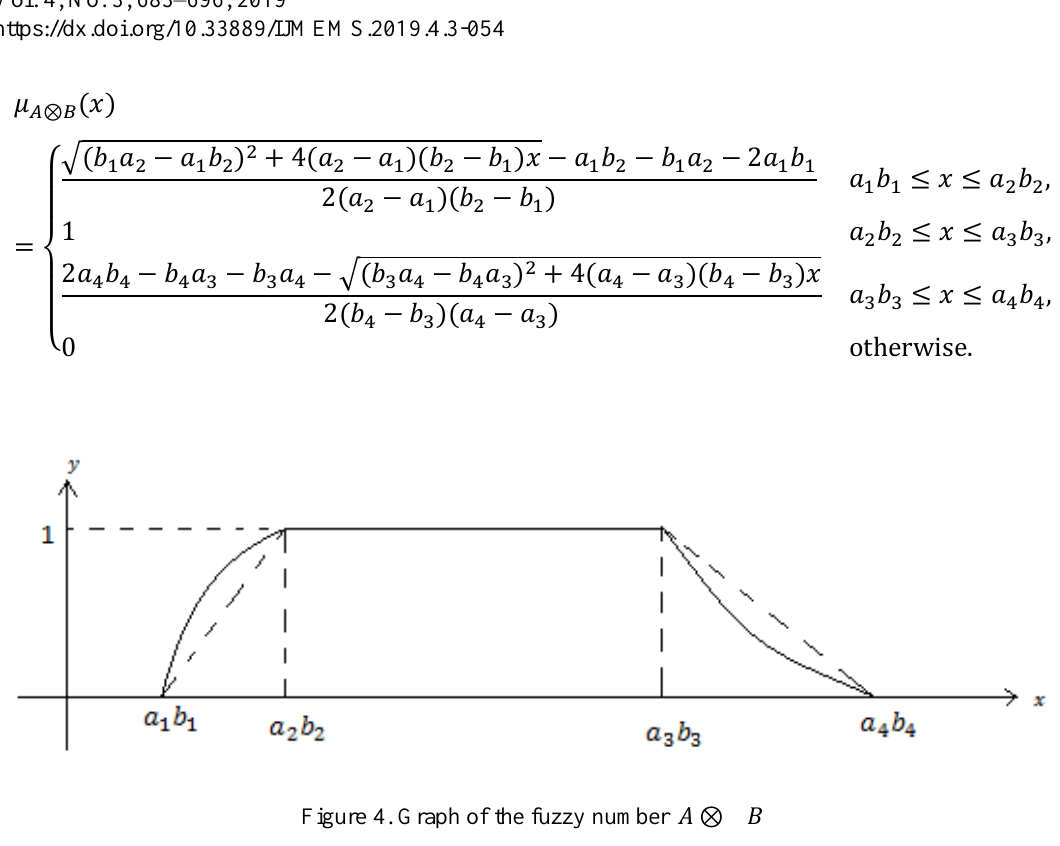
Figure 4. Graph of the fuzzy number 𝐴 ⊗